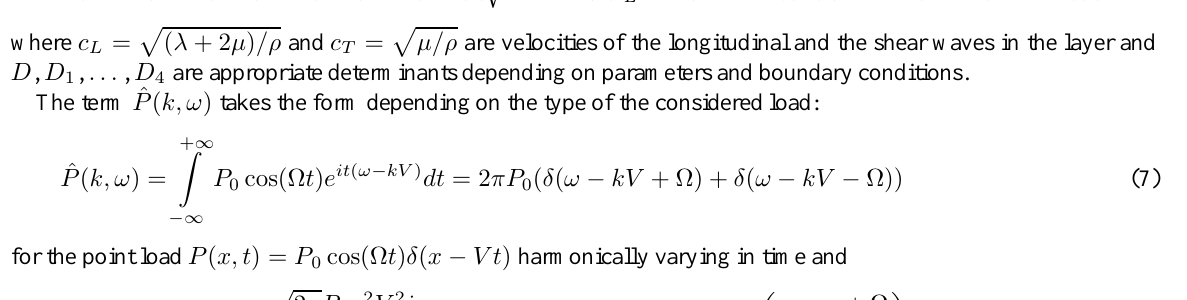
− D ) − ik ( D + D )) /D 1 2 3 4